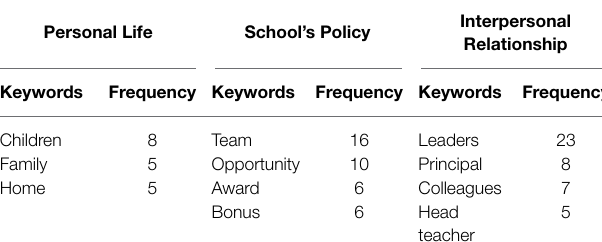
TABLE 5 | Keywords and frequency of each dimension of hygiene